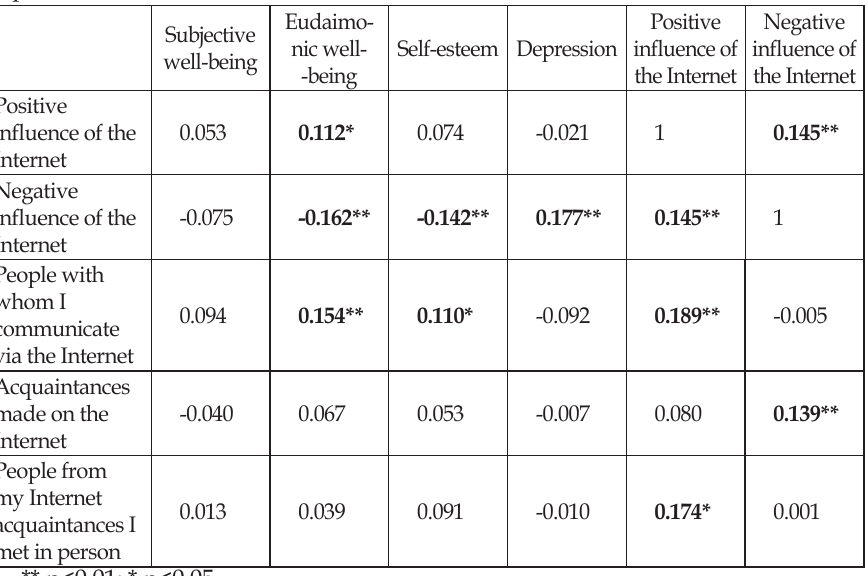
Table 4. Results from correlation analyses of positive and negative in fl uence of the Internet, communicational aspects of the Internet, well-being, self-esteem and